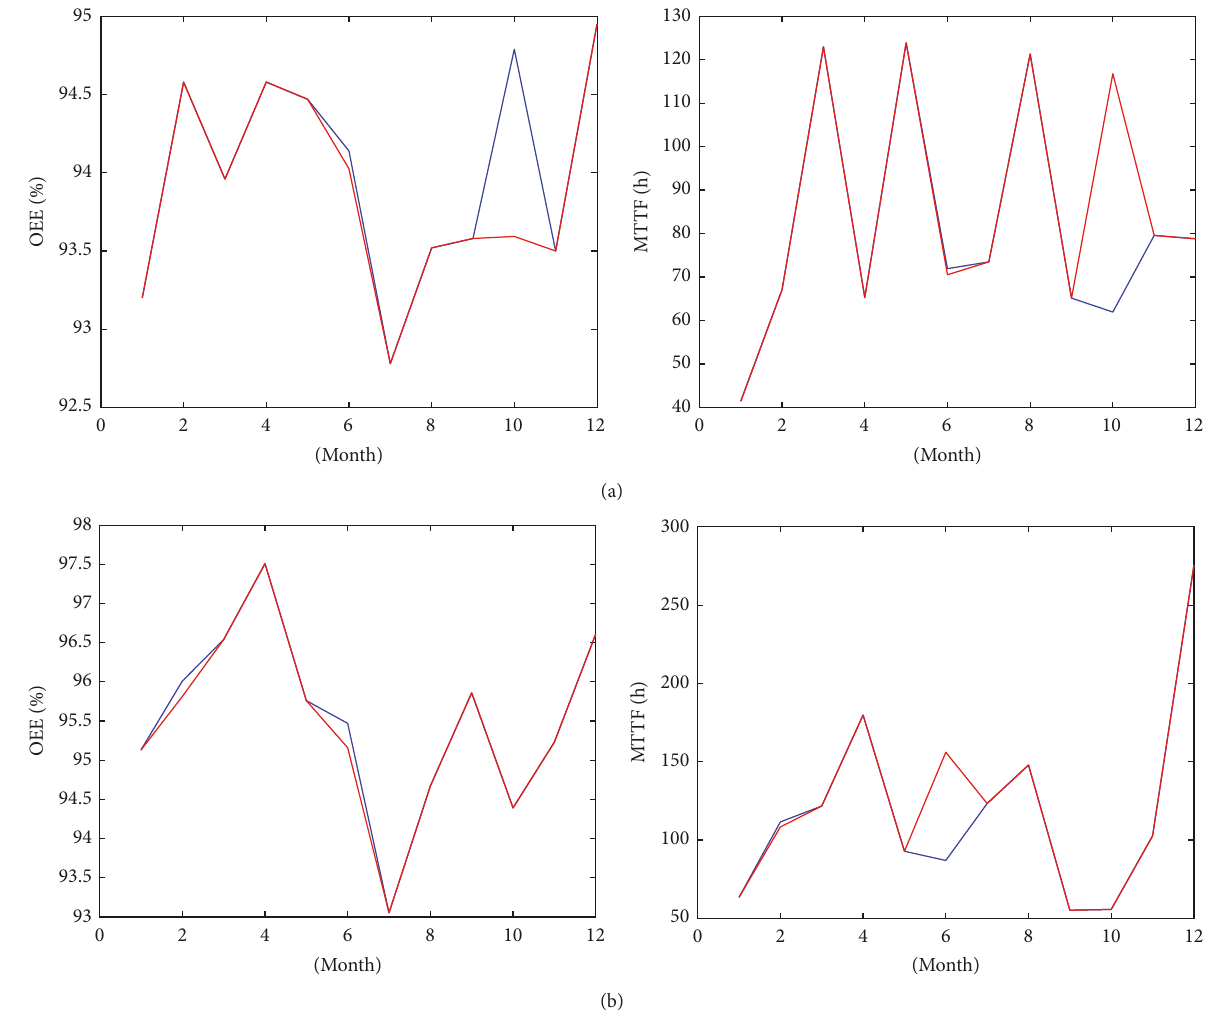
Figure 9: Output variables measure (blue) versus predicted (red): (a) M1; (b)